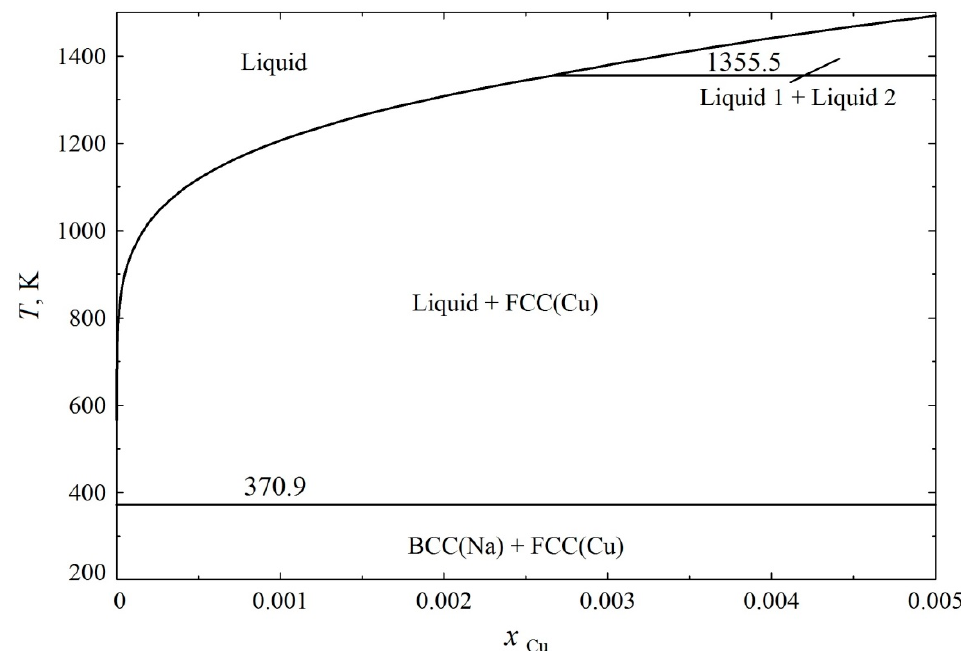
Figure 3. Calculated phase diagram of the Na-Cu system. Zoom for the area with low copper concentration.